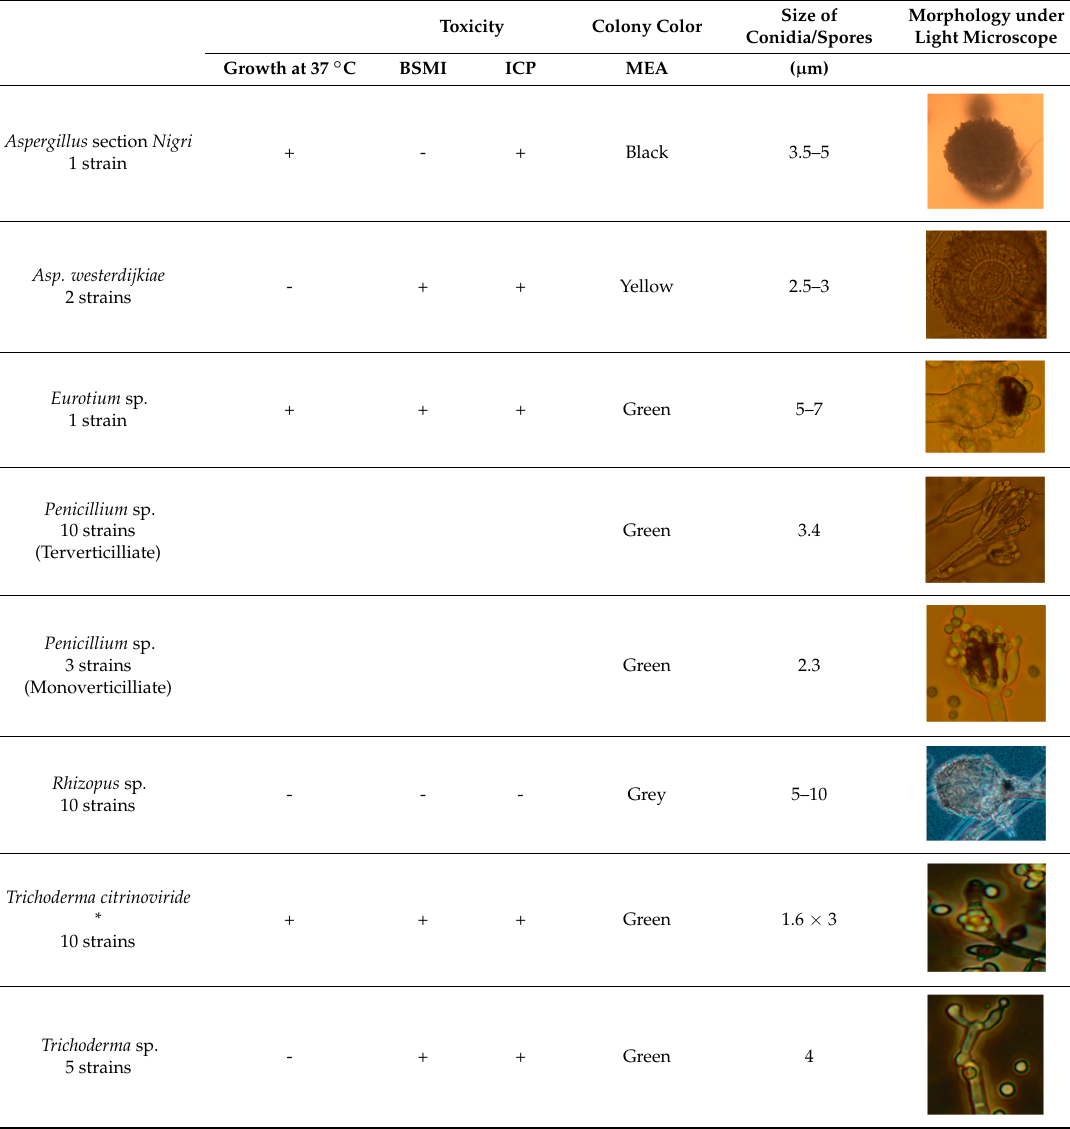
Table 3. The eight fungal morphotypes isolated from settled dust collected before and after the ventilation improvement, characterized by toxigenicity, pathogenic potential, and conidiophore morphology.